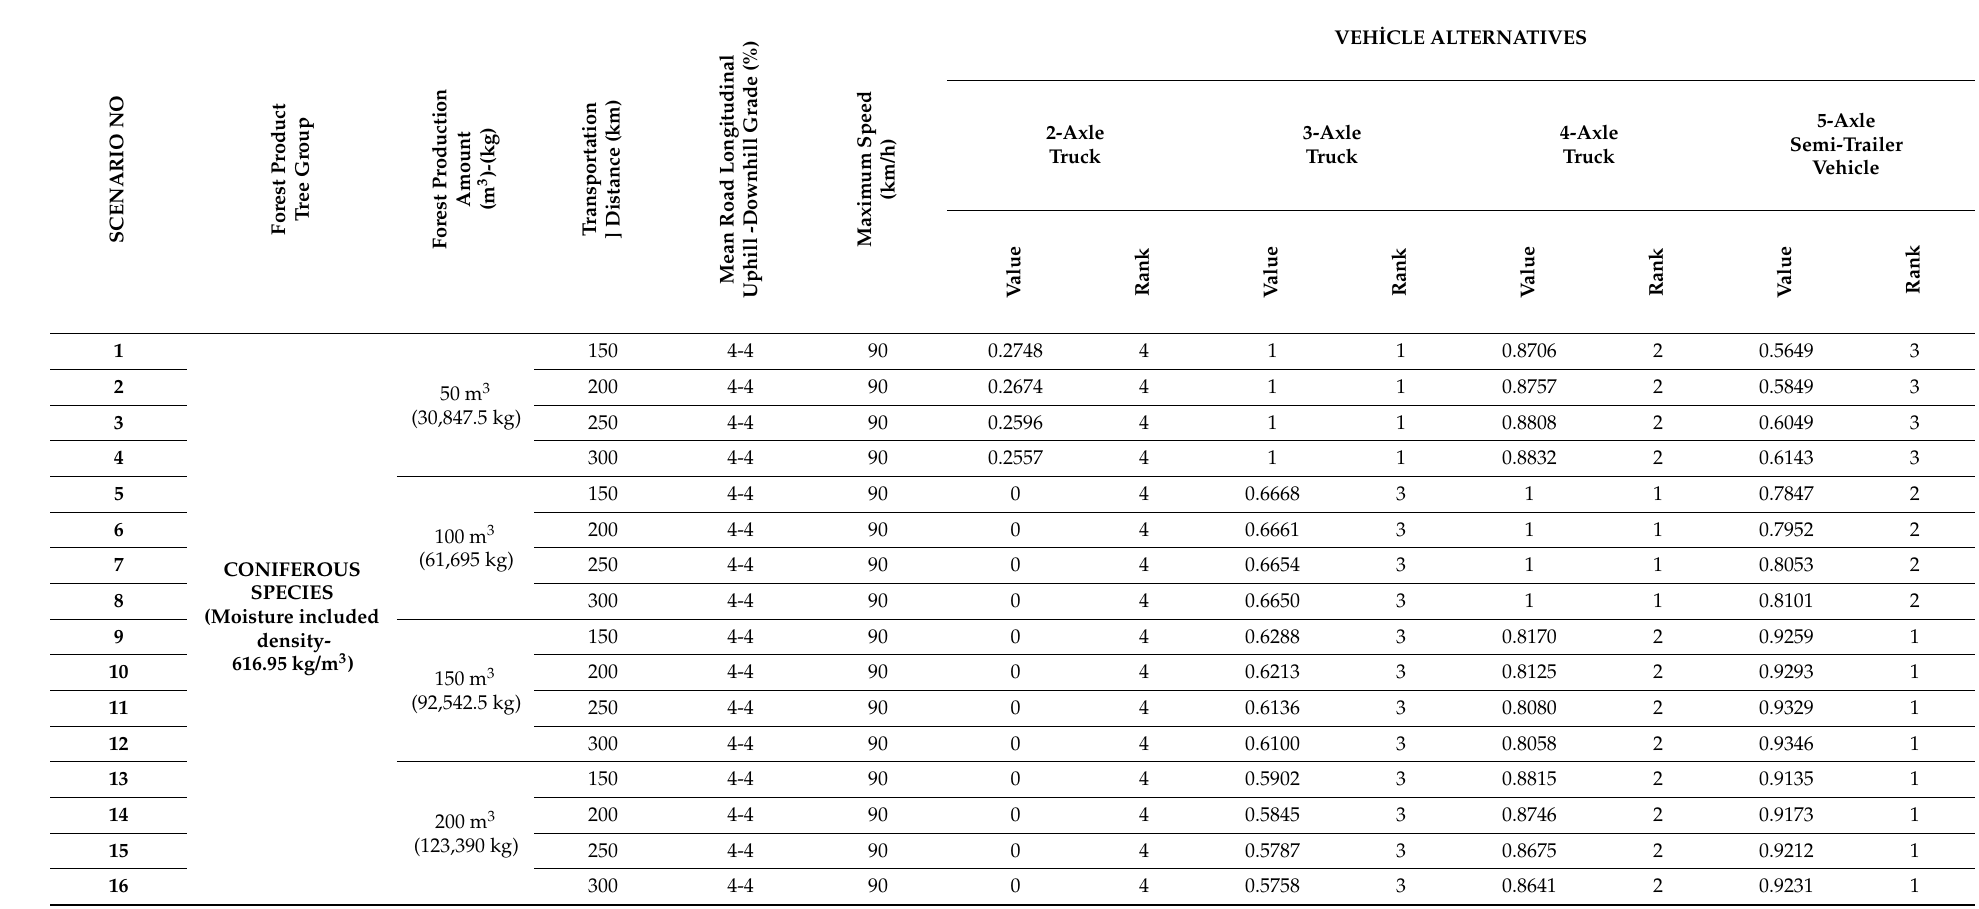
Table 23. The ranking of the vehicle alternatives according to the transportation scenarios for coniferous tree